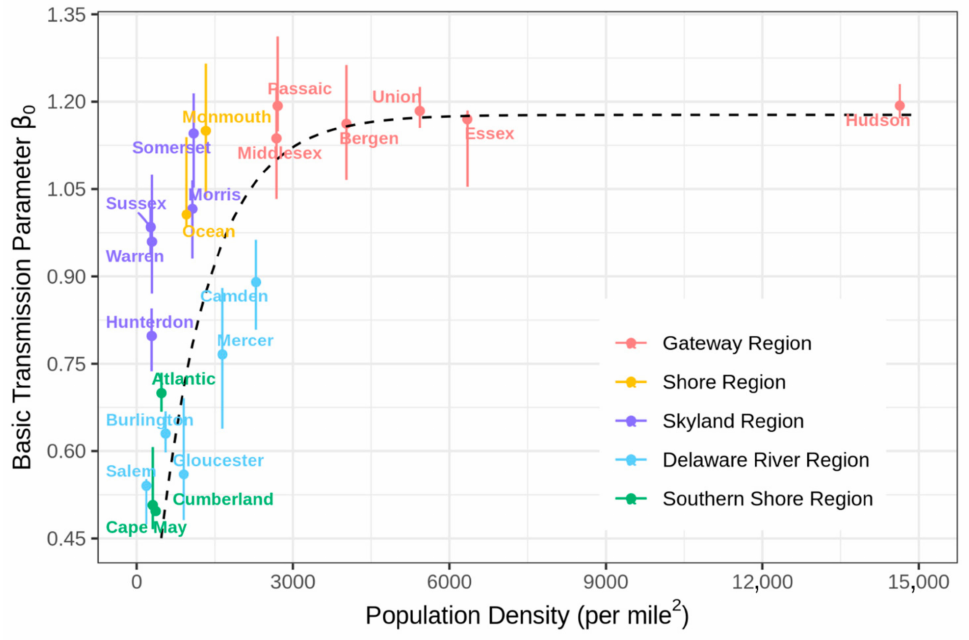
Figure 9. Nonlinear relationship between the estimated county level transmission rates and county population density. The black dashed line is a fitted mechanistic nonlinear scaling function consistent with kinetic theory modeling as described in